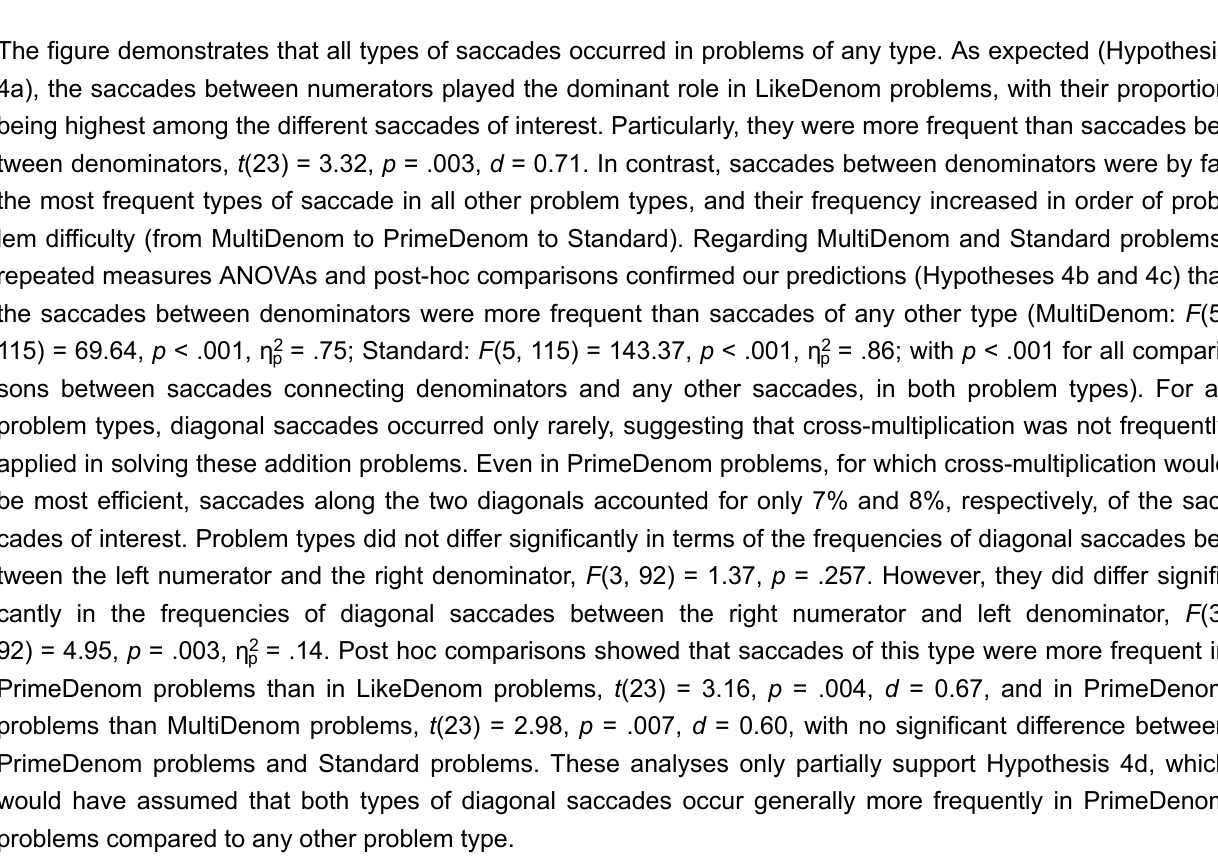
Figure 1. Proportions of saccades within each problem type. Note . Error bars indicate standard errors of the mean. Percentages refer to the distribution within each problem type. The sum of percentages within each problem type may deviate slightly from 100 due to